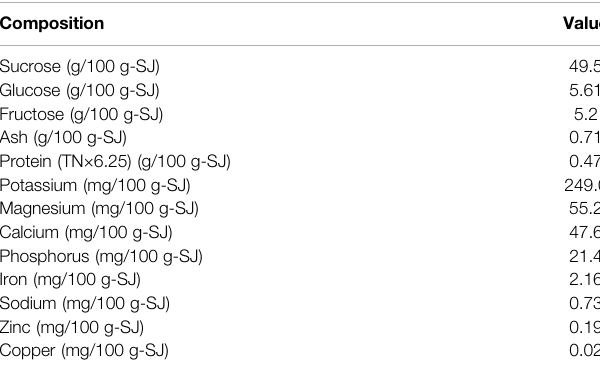
TABLE 1 | Compositions of concentrated sugarcane juice used in the present study.